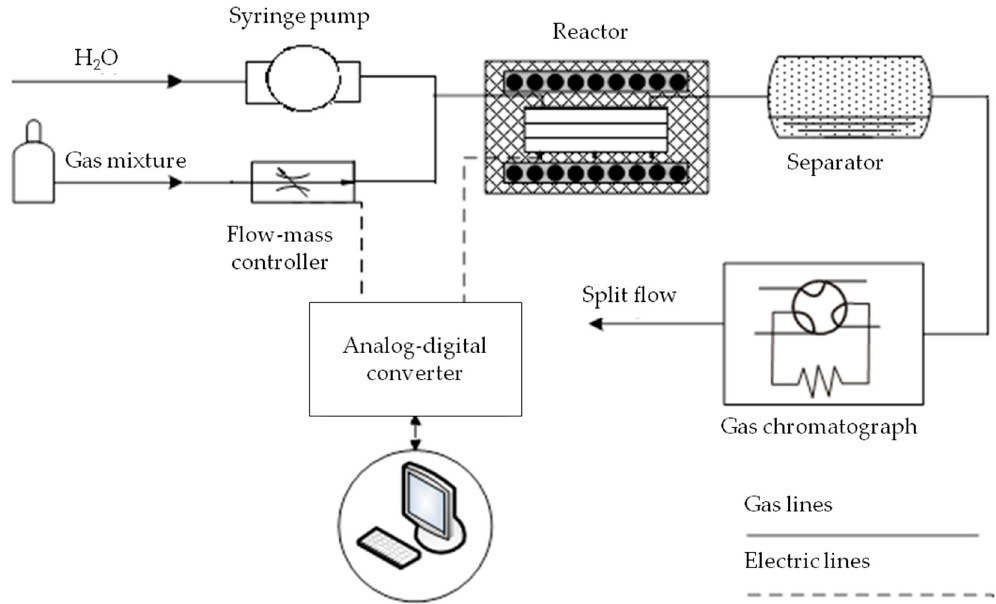
Figure 20. Image of the experimental setup for the WGS reaction in the microchannel reactor.